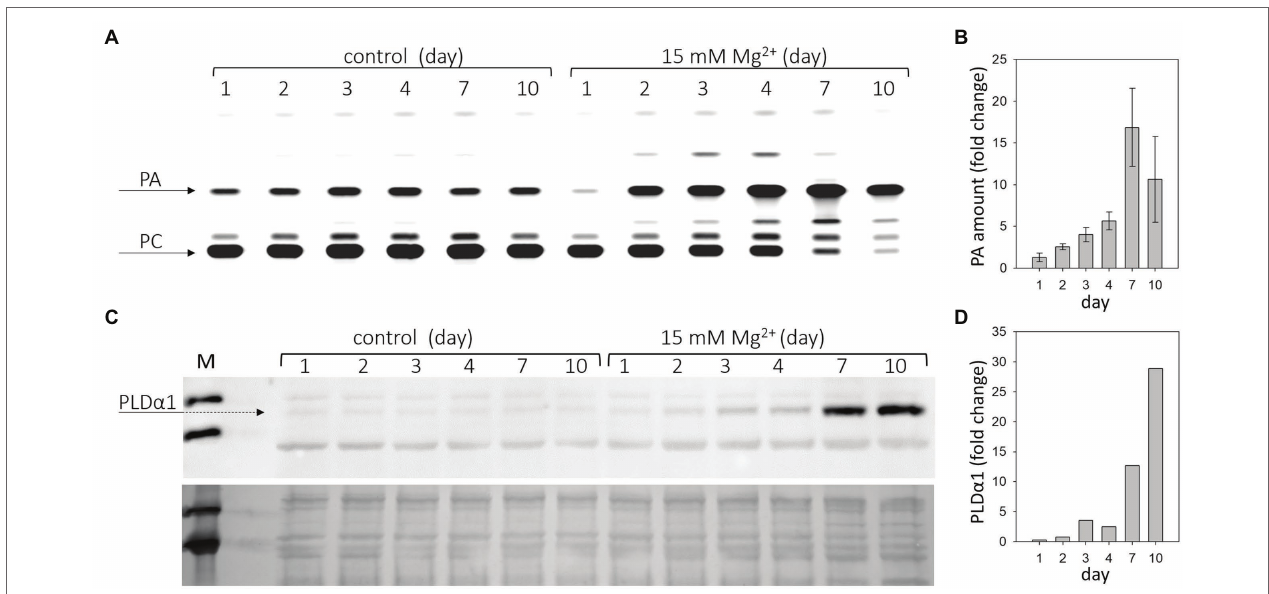
FIGURE 1 | Phospholipase D α 1 (PLD α 1) activity and amount increases in response to high Mg 2+ stress. Twenty-four-day-old hydroponically grown plants were treated with 15 mM MgSO 4 and sampled after 1, 2, 3, 4, 7, and 10 days after the treatment. (A) Thin layer plate showing phosphatidic acid, product of PLD α 1 activity. PLD α 1 activity was measured in leave extracts from leaves 3–6 from plants treated with MgSO 4 . (B) Relative increase of PA with MgSO 4 treatment over time. Values represent mean ± SE, n = 3 biological experiments. (C) Western blot detection of PLD α 1 in protein extracts from leaves. Each lane was run with 15 μ g of protein, upper panel – western blot, lower panel – loading control – membrane stained with Novex reversible membrane protein stain. (D) Quantification of PLD α 1 protein. The experiments were repeated three times with similar results. PA, phosphatidic acid; PC, phosphatidylcholine; and M, molecular